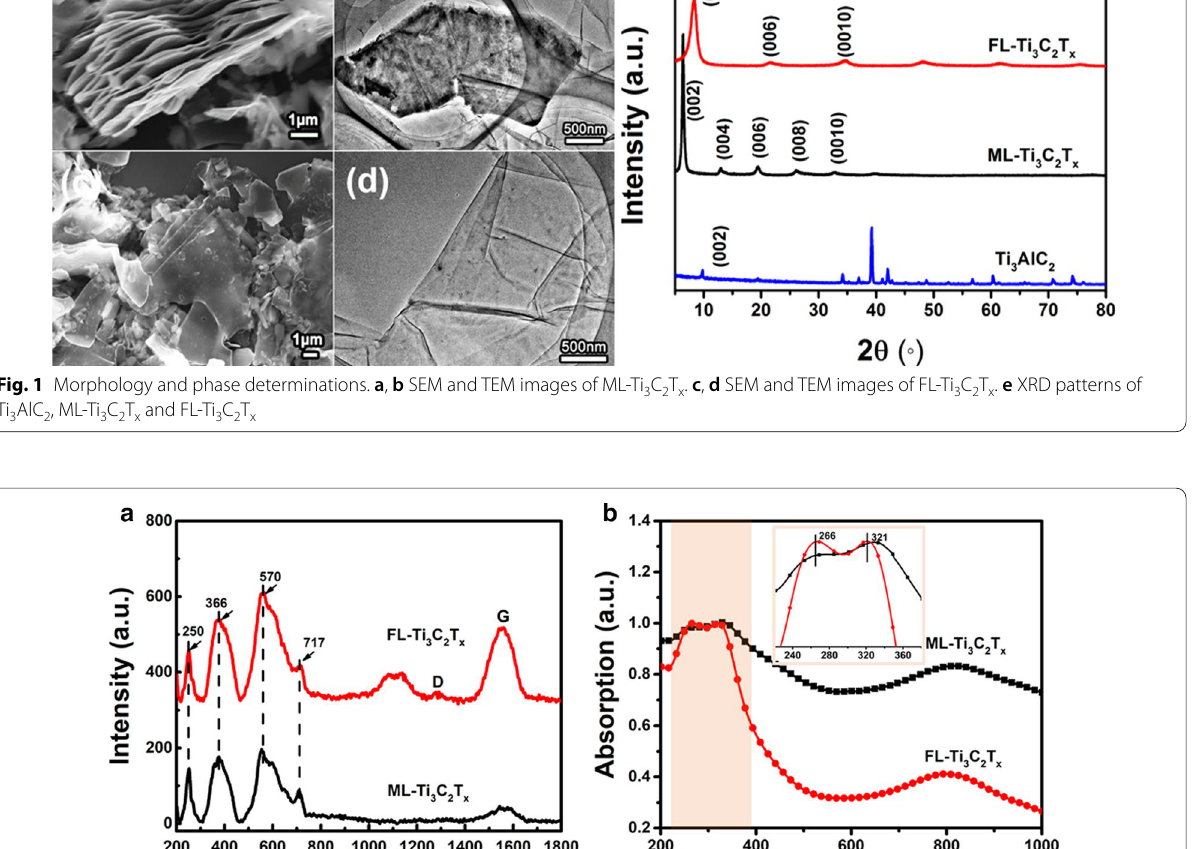
Fig. S1, which further confirm that FL-Ti 3 C 2 T x are termi- nated by more groups with negative charges.